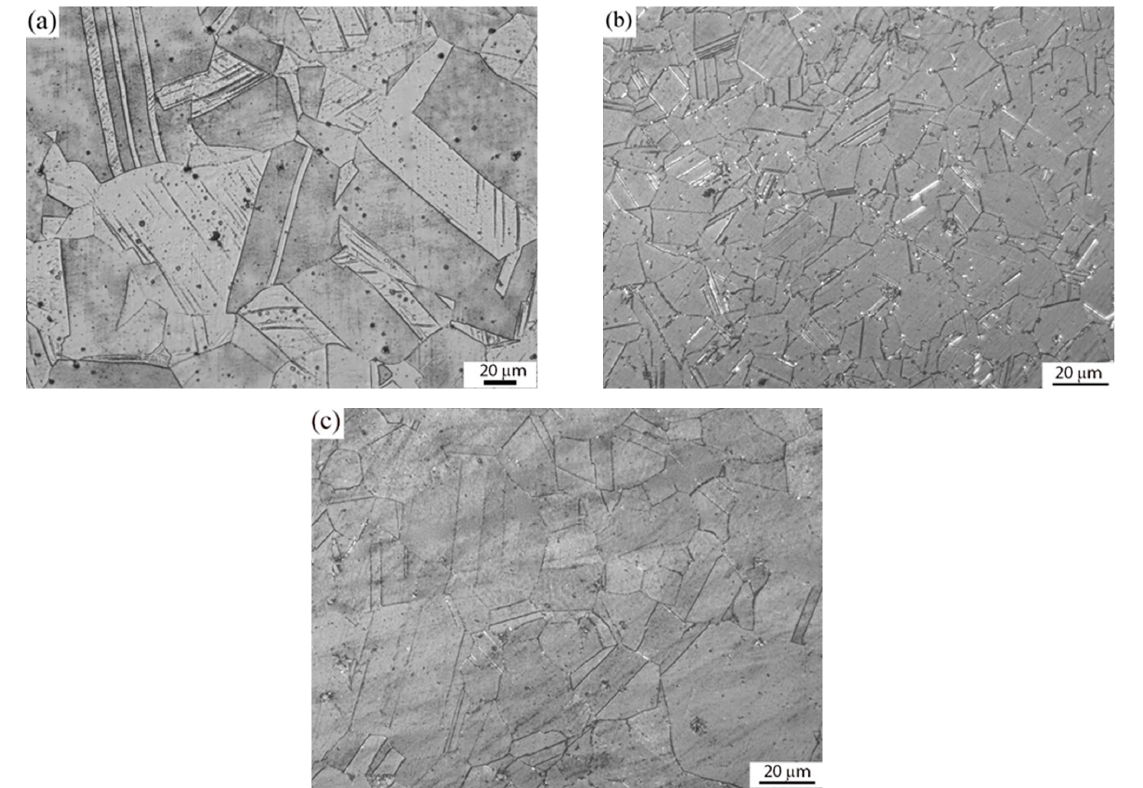
Figure 2. Optical micrographs of ( a ) AISI 316L, ( b ) Inconel 718 ST, and ( c ) Inconel 718 STA base metals.